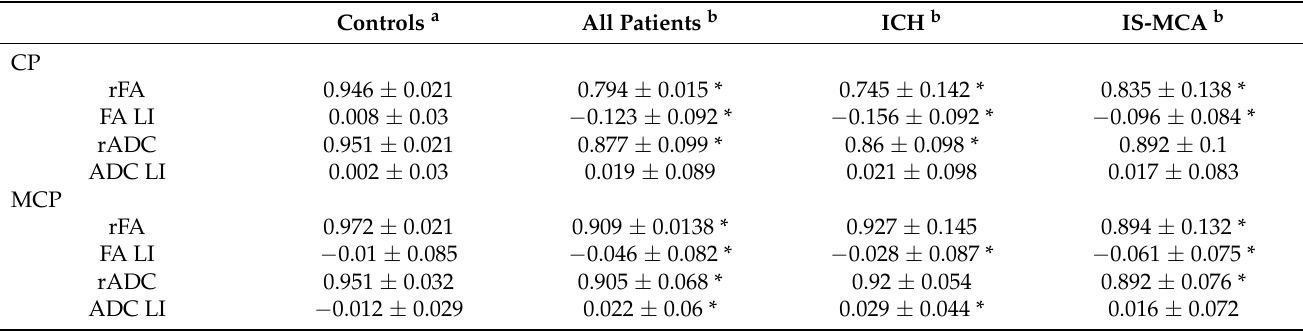
Table 2. DTI parameter in controls and